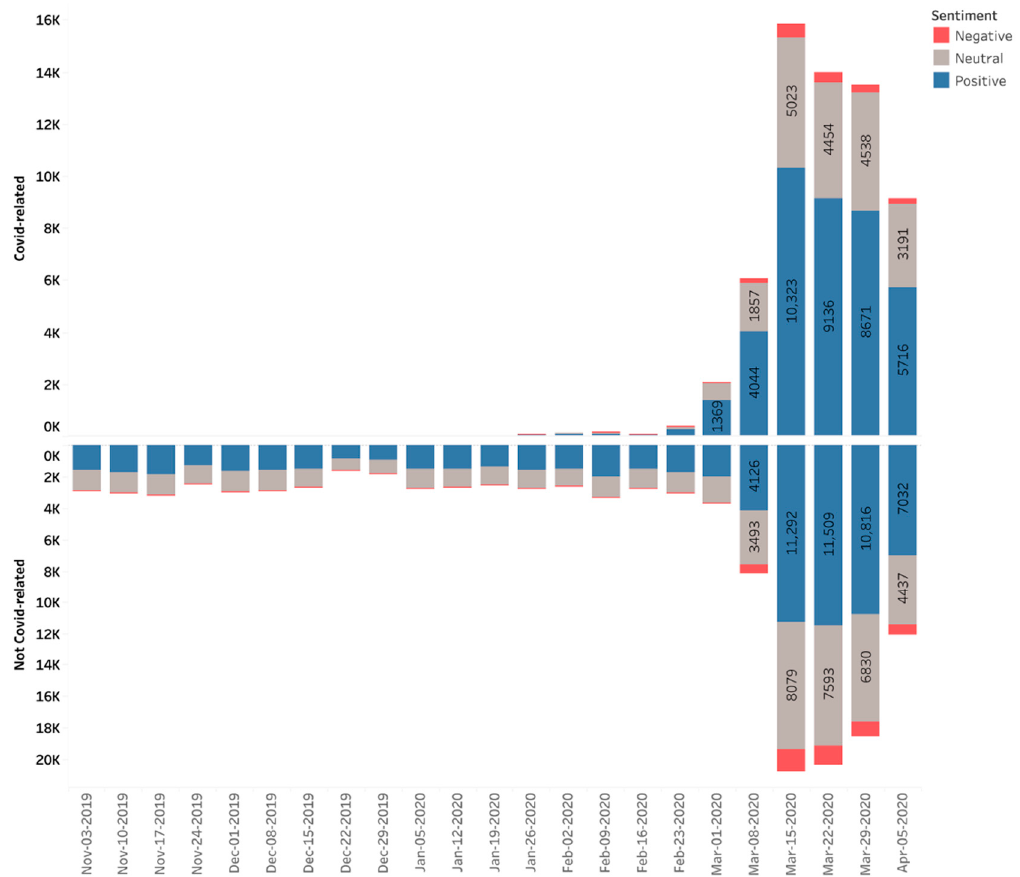
Figure 2. Telehealth tweets related to COVID-19 and unrelated to COVID-19.